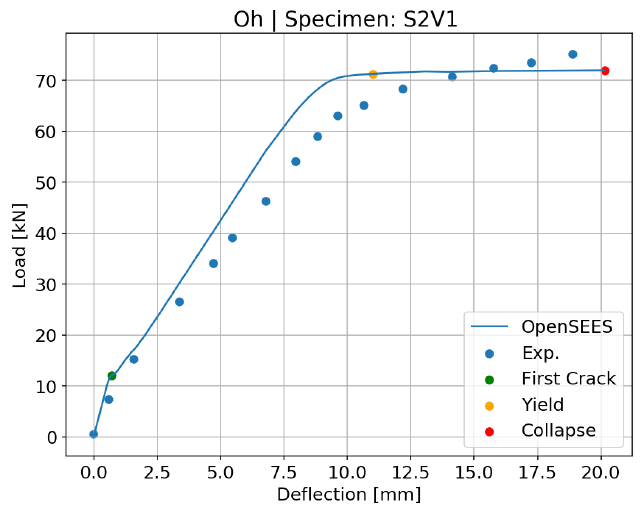
Figure 4. Numerical model results for specimen S2V1 tested by Oh